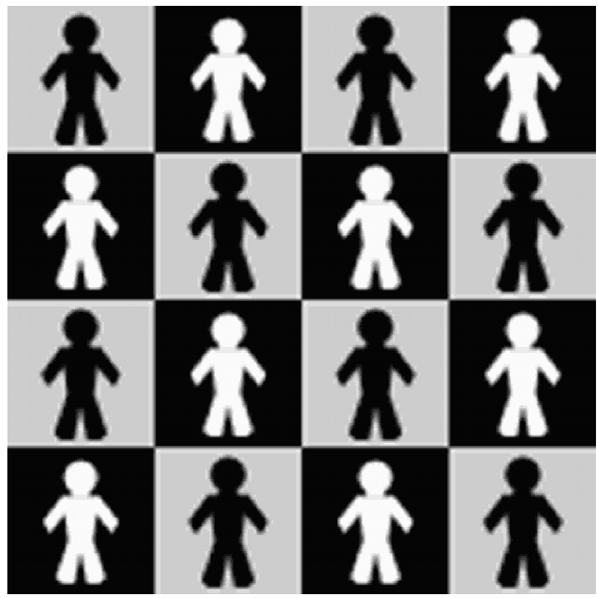
Figure 2. Toroidal grid of 4 6 4 cells with 8 white and 8 black agents distributed in the way shown. In this particular spatial distribution the system may reach the IQ state in both intratype games whenever similar tagged agents placed in the same column demand exactly the complementary quantity (L or H) of their neighbours of columns just next to them. This result is true if the intratype network is bipartite, i.e. there are no odd-length cycles.